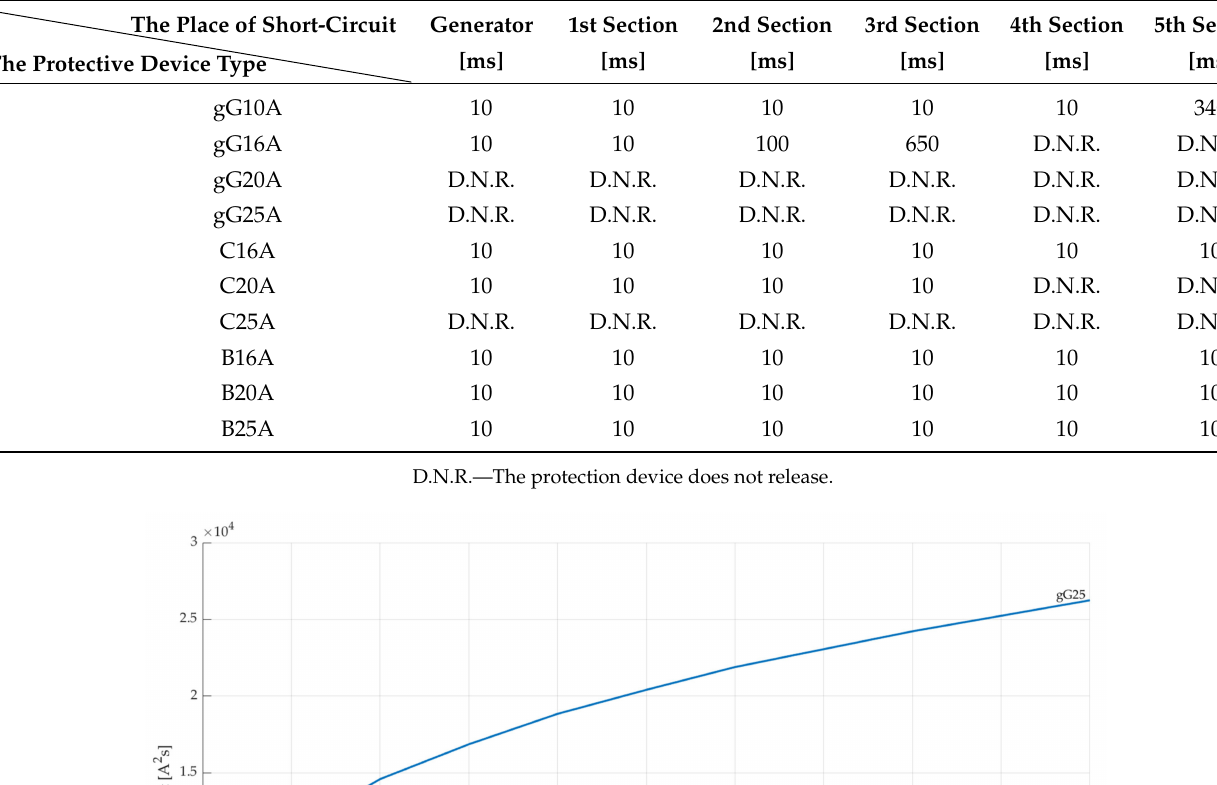
Table 5. The off-switching times for different fault places and protective device types.